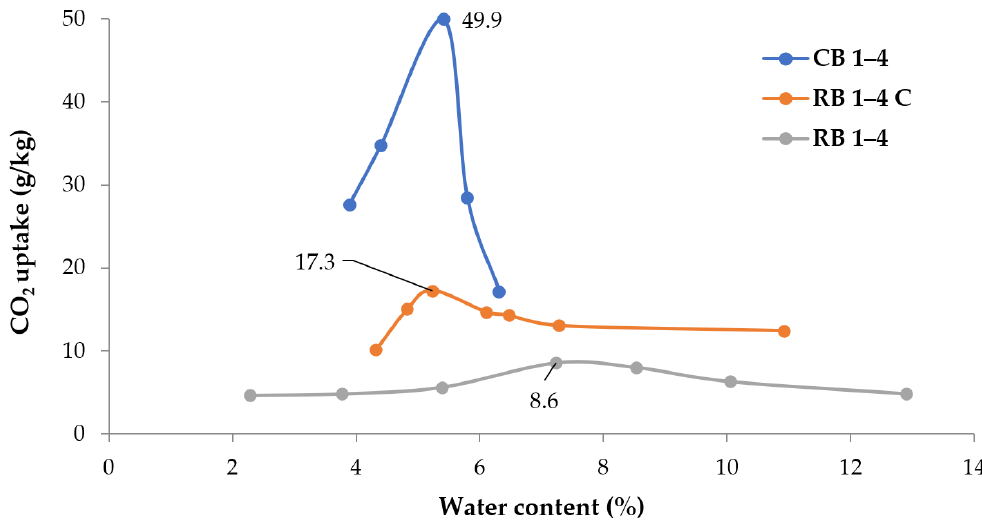
Figure 4. Effect of the initial natural carbonation of an RCA on CO 2 uptake as a function of the water content (one accelerated carbonation test for these RCAs at these water contents).